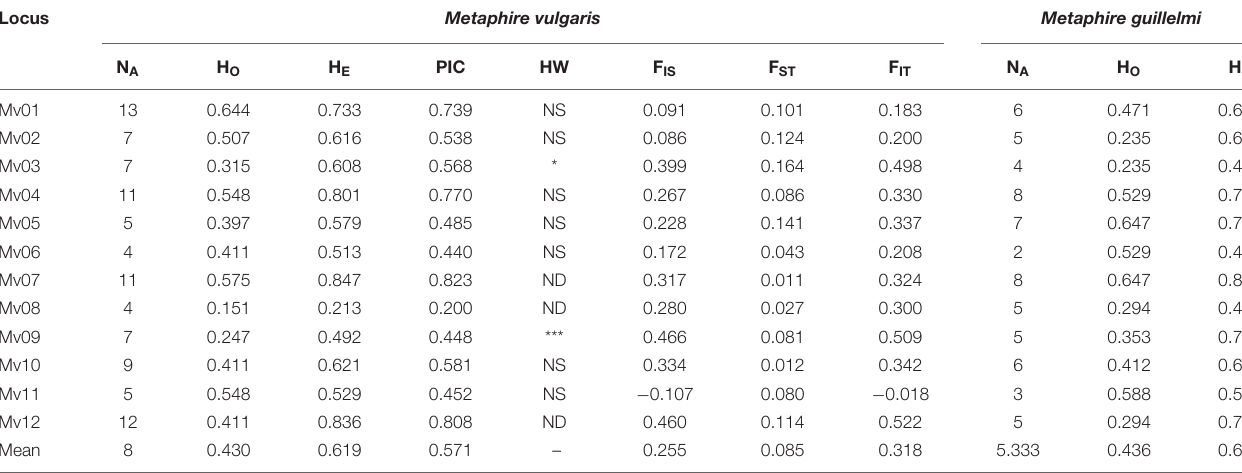
TABLE 4 | Polymorphism of the 12 microsatellite loci for Metaphire . Locus Metaphire